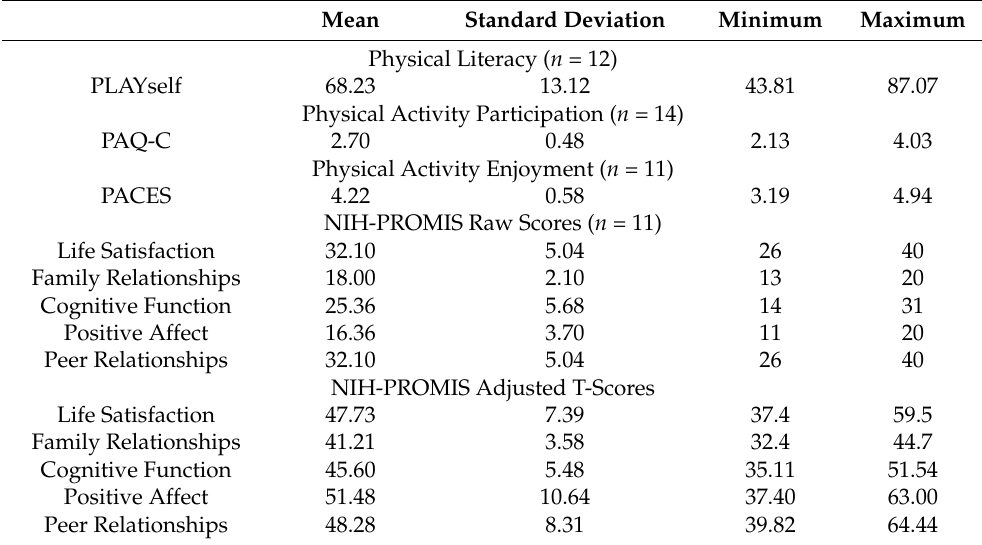
Table 1. Participants’ physical literacy, physical activity participation, physical activity enjoyment, and mental and social health